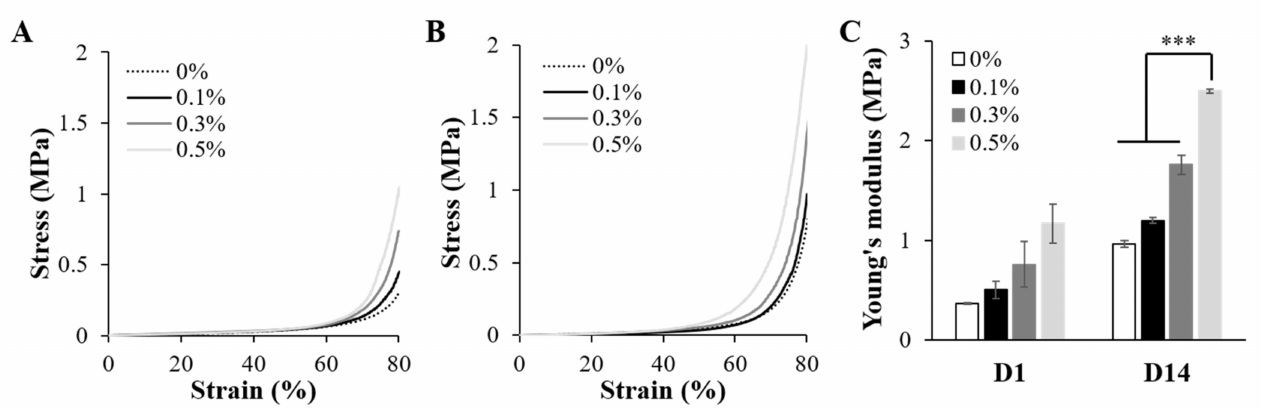
Figure 9. Mechanical properties of the cell cultured 3D scaffolds. ( A , B ) Compressive stress–strain curves of the cell cultured 3D scaffolds at ( A ) 1 day and ( B ) 14 days of culture. ( C ) Young’s modulus of the cell cultured 3D scaffolds ( n = 4) (*** p <